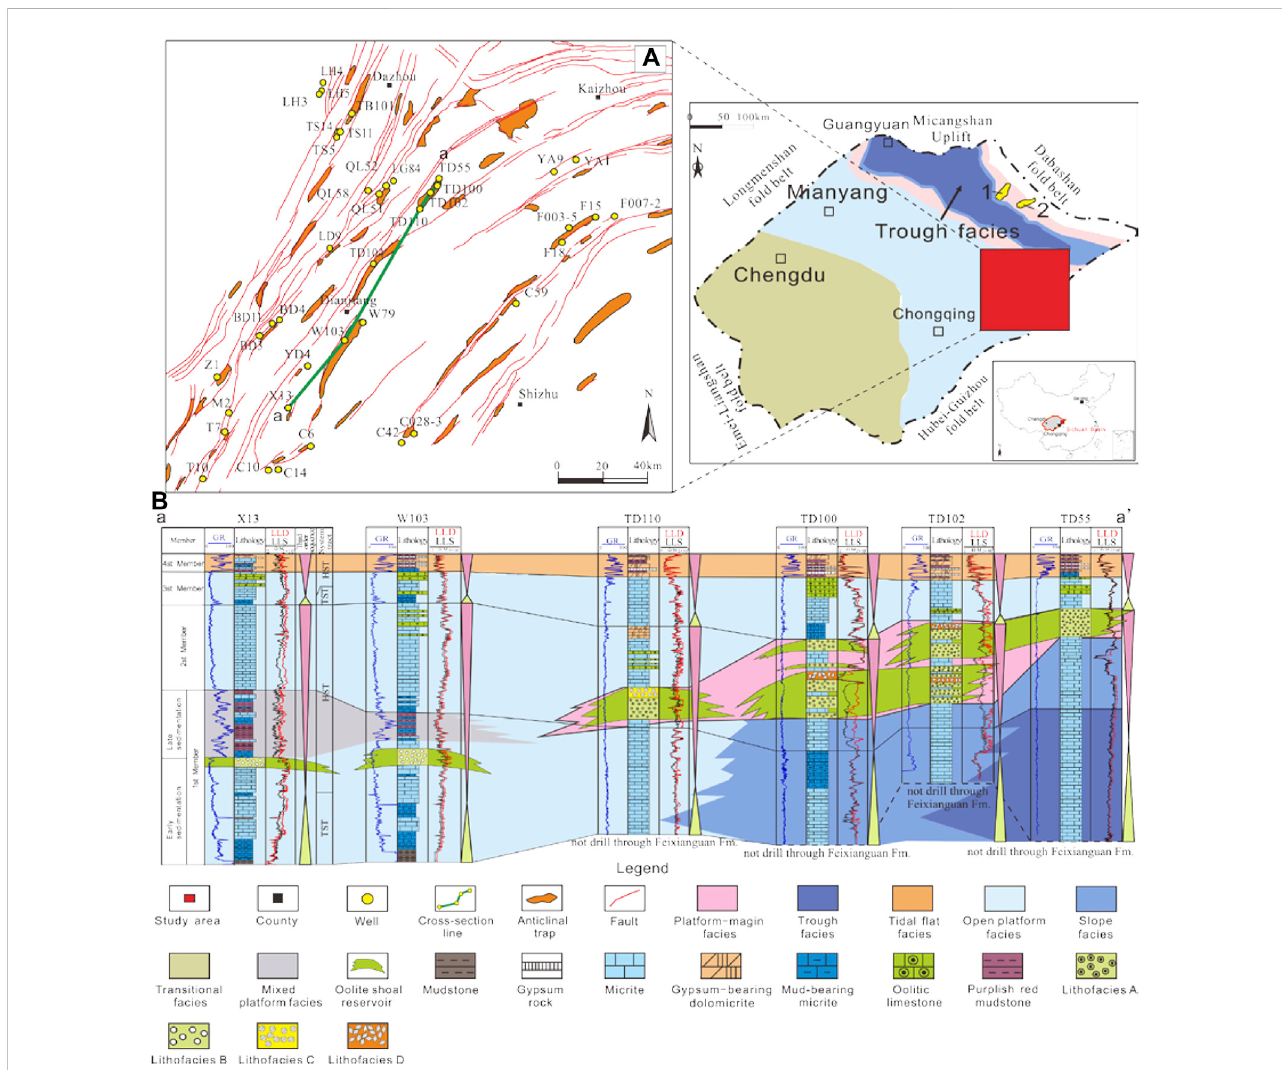
FIGURE 1 Geological setting of Feixianguan Formation in the study area. (A) Location of the study area in China and locations of the representative wells; the numbers 1 – 2 represent Puguang and Luojiazhai – Gunziping gas fi elds, respectively. (B) Cross-well section of sedimentary facies and the stratigraphic